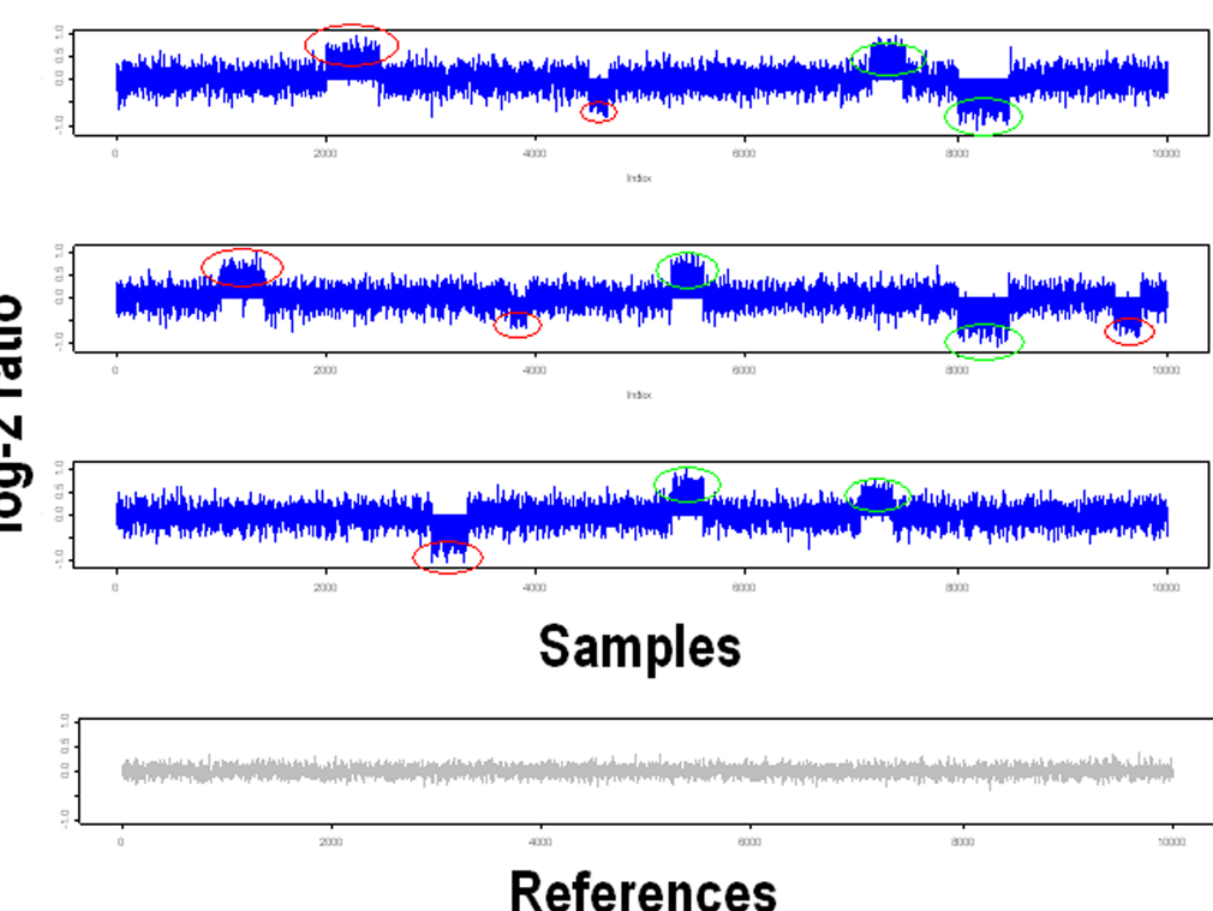
Figure 2. CNA regions selected by CMA algorithm. Compared with the references, the regions with circles indicate the CNA regions. For different samples, the CNA regions may occur in the different locations. Some appear repeatedly (the ones with green circles), and some others rarely occur (the ones with red one).